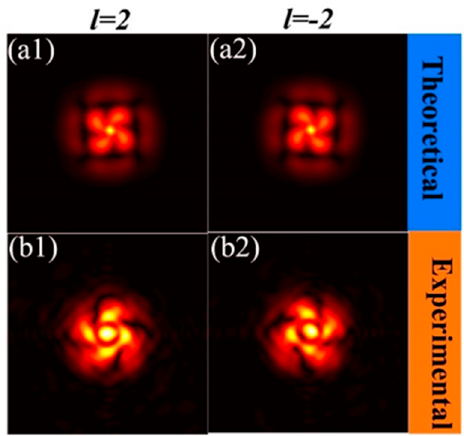
Figure 11. The modulus of the DOC ( | µ ( ρ ,0; z ) | ) of a focused HGCSMLG 0l beam at z = 0.68 f with m = 1, n = 1.